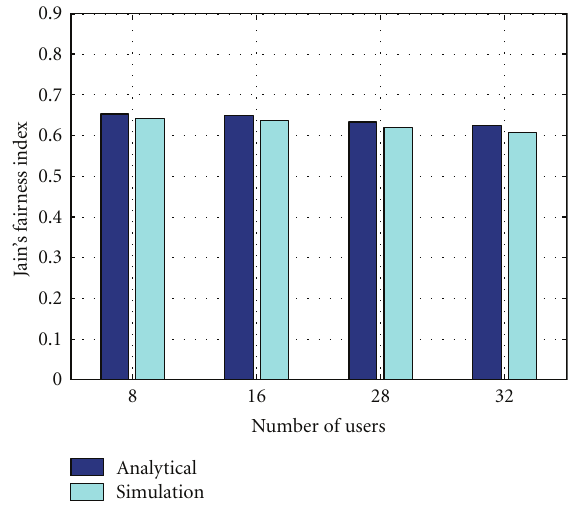
Figure 8: Throughput versus the number of subbands (tra ffi c load = 250